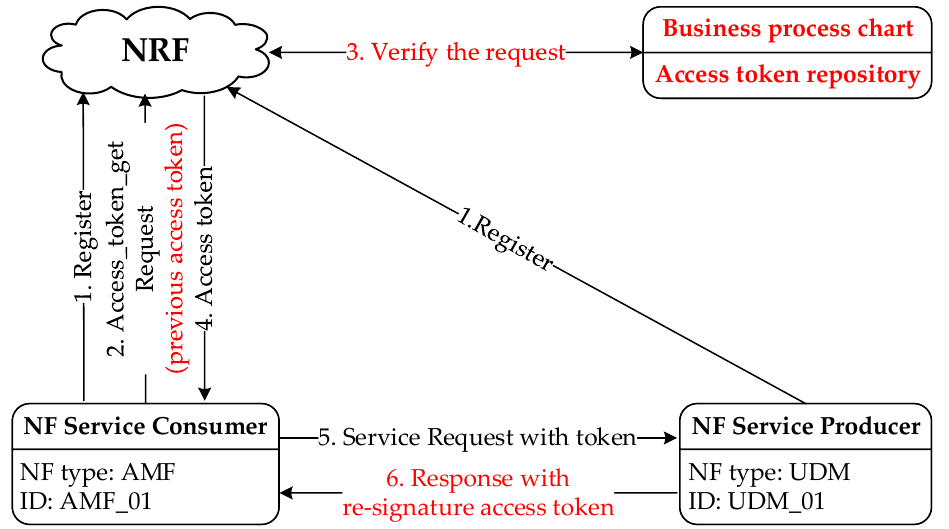
Figure 3. NF Interaction